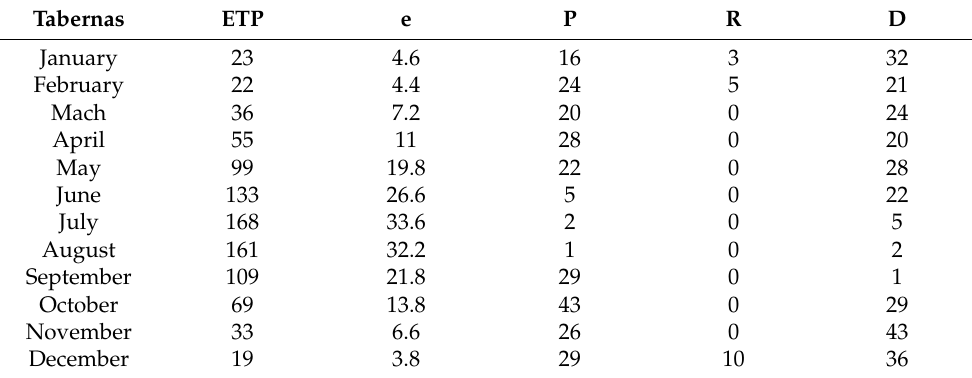
Figure 6. Bioclimatic diagram for Tabernas: P = precipitation, ETP = potential evapotranspiration, D = water availability, R = soil water reserve, e = residual evapotranspiration (mm. water); Y: mm. Water; X: Month year. Table 3. Parameters for Tabernas: potential evapotranspiration (ETP), residual evapotranspiration (e), precipitation (P), soil water reserve (R), water availability for plants